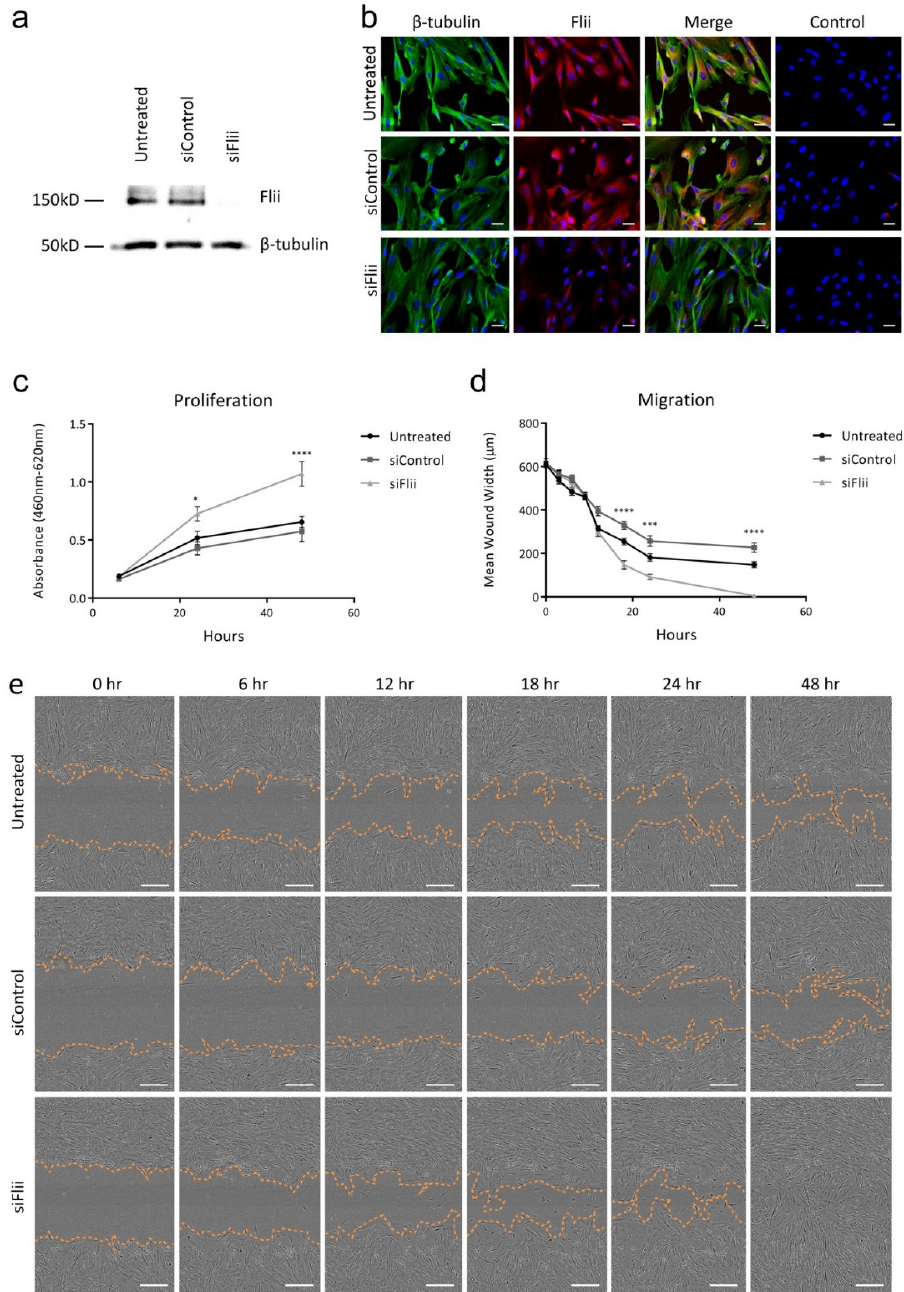
Figure 2. ( a ) Flii knockdown by siRNA as shown by Western Blotting of untreated, siControl- and siFlii-treated human pericytes from placenta (hPC-PL) cell lysates 48 h after knockdown. ( b ) Flii knockdown by siRNA as shown by immunocytochemical staining of untreated, siControl- and siFlii-treated hPC-PL cells 48 h after knockdown. No primary antibody-treated hPC-PL cells are shown as control. Images taken at 40 × objective, scale bar = 20 µ m. ( c ) E ff ect of Flii knockdown on hPC-PL proliferation in a WST1 proliferation assay. Data displayed as mean ± SEM, n = 6. Results are representative of three independently conducted experiments. ( d ) E ff ect of Flii knockdown on hPC-PL migration in a scratch wound assay. Data displayed as mean ± SEM, n = 6. Results are representative of three independently conducted experiments. ( e ) Images representative of untreated, siControl-treated and siFlii-treated hPC-PL scratch wounds at 0, 6, 12, 18, 24 and 48 h. Images taken